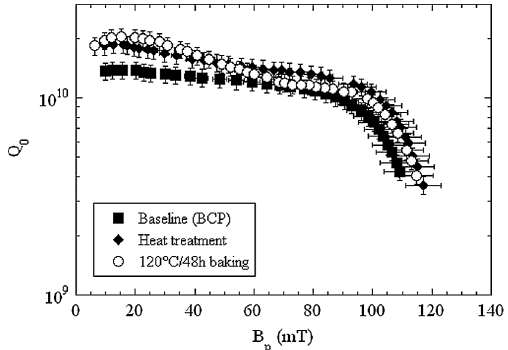
h.FIG. 16. Q vs B measured at 2.0 K on a ‘‘rolled’’ single- p 0 crystal ILC single-cell cavity after the baseline test (squares) and after the heat treatment (triangles) at 800 (cid:1) C = 3 h , 400 (cid:1) C = 20 min injection, 120 (cid:1) C = 6 h . The round sym- with 1 (cid:5) 10 (cid:2) 5 mbar N 2 bols are the data after additional in situ baking at 120 (cid:1) C for 48